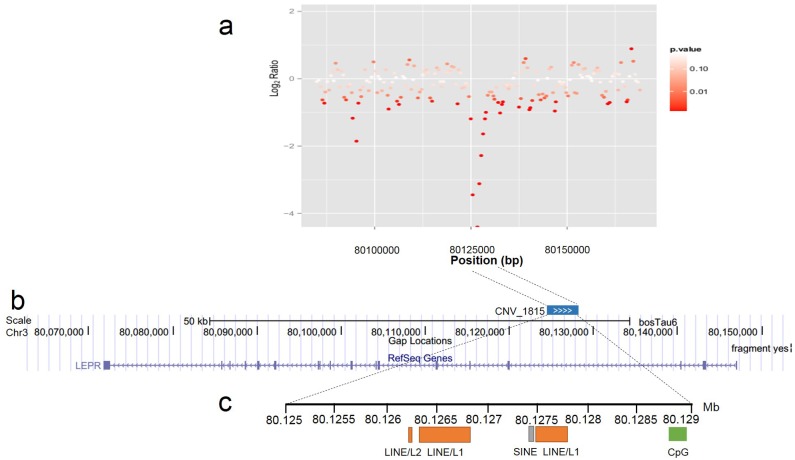
The bovine Lepin receptor (LEPR) gene overlapping with copy number variation (CNV) region.a represented log2 ratio plot of the LEPR gene region. Each point shows the log2 ratio of Nanyang reads mapped to Qinchuan reads. Points are coloured based on the log10 p-value calculated by the CNV-seq software. b represented the LEPR gene region as visualized using the UCSC Genome Browser. The precise boundary of the CNV_1815 that resides in this region is shown and labelled. c represented the localization and composition of important elements in the CNV_1815. The small bars in orange are partial LINEs, and the gray shows SINEs. A small CpG island is marked with a green bar.